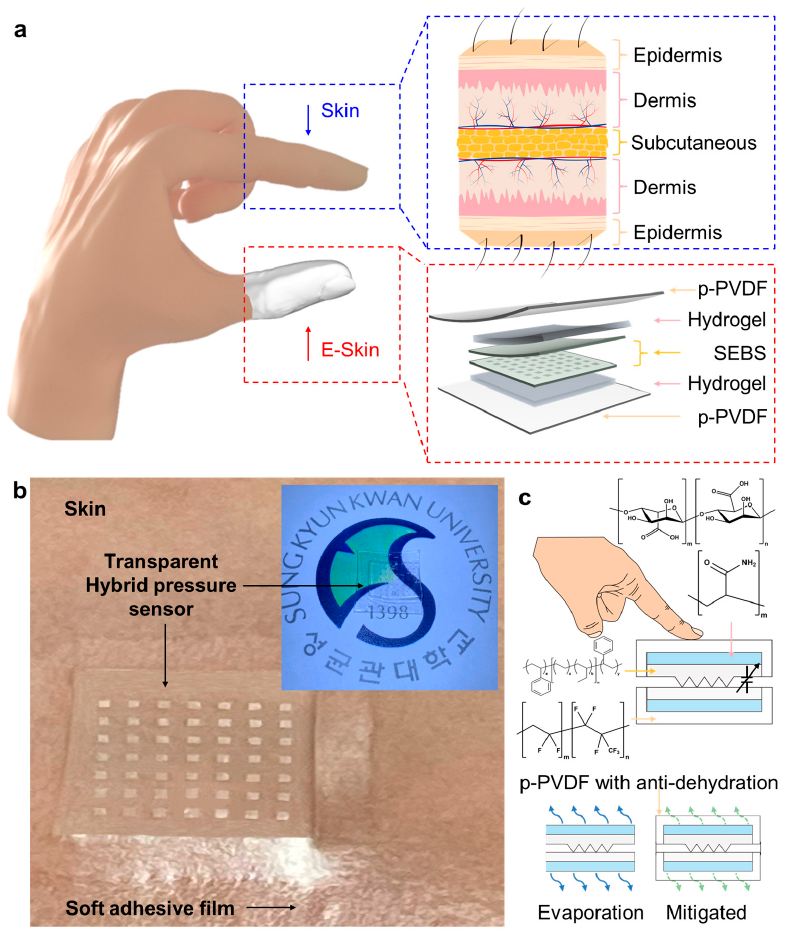
Figure 1. ( a ) Overall schematic illustration of the transparent hybrid soft pressure sensor. ( b ) Pho- tograph of the transparent polymer-hydrogel hybrid pressure sensor. Inset image shows the better transparency of the sensor. ( c ) Schematics for the underlying mechanism of pressure sensing based on the sensor and the materials strategy of long-term stable pressure sensing using p-PVDF-based self-bonding